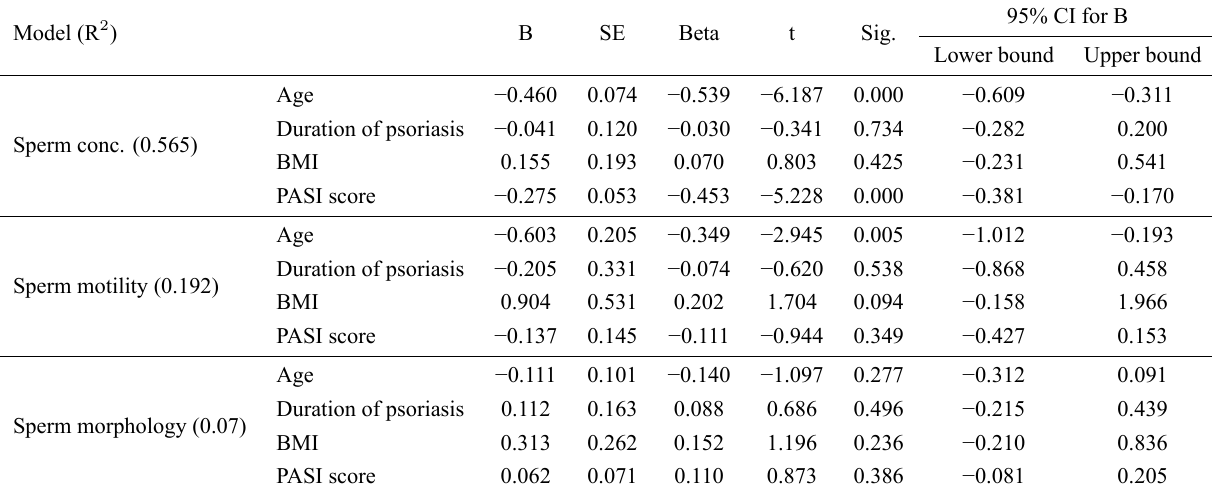
Table 2. Regression analysis of demographic and clinical characteristics and parameters of semen